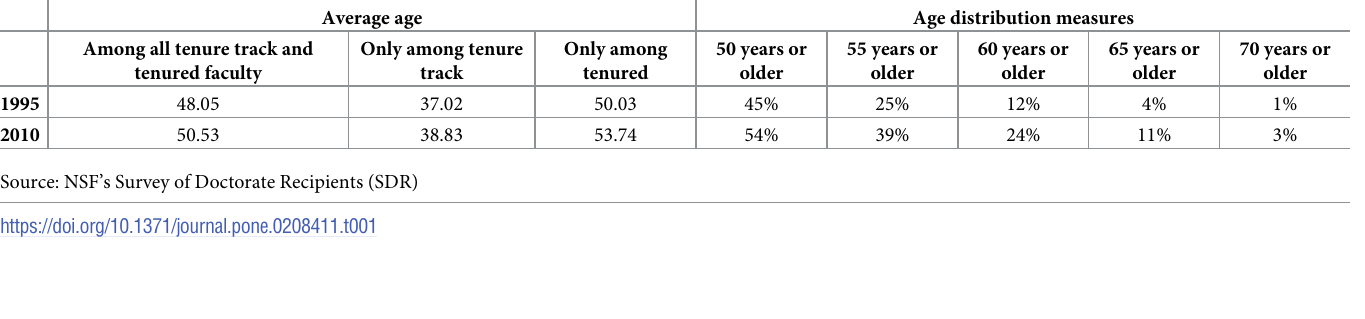
Table 1. Changes in age measures of faculty members between 1995 and